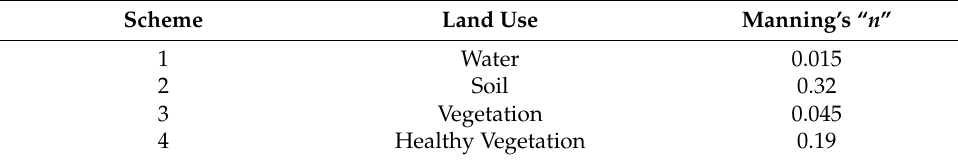
Table 2. The estimated Manning’s n value for different land use